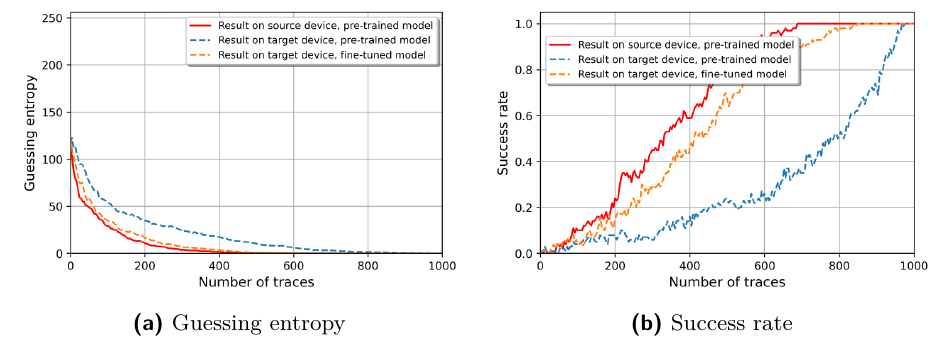
Figure 18: Attacking results on CHES CTF 2018.